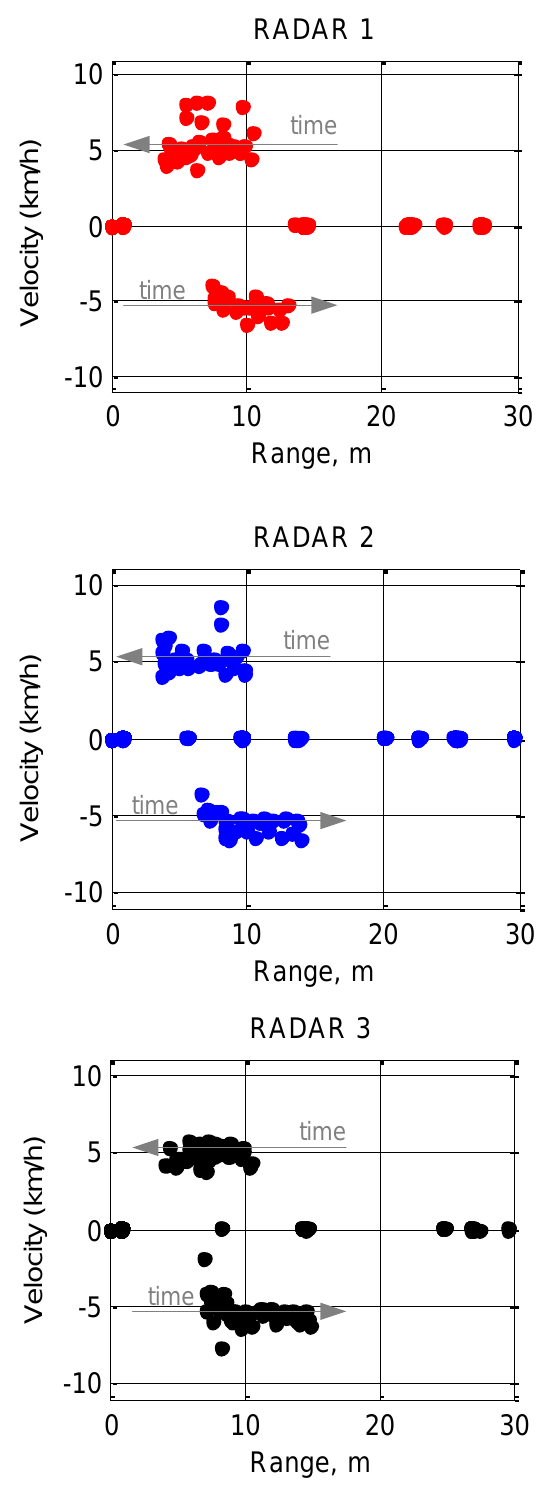
Figure 13. Detection map of the three sensors after OSCA-CFAR